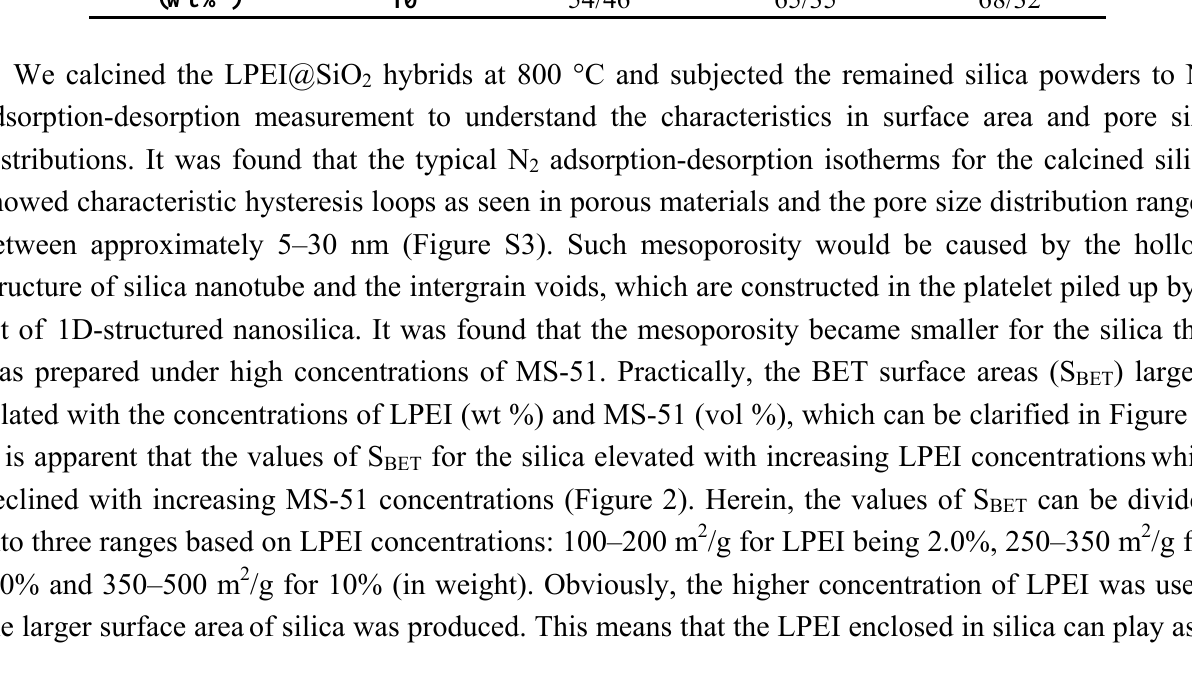
Table 2. Composition of LPEI@SiO